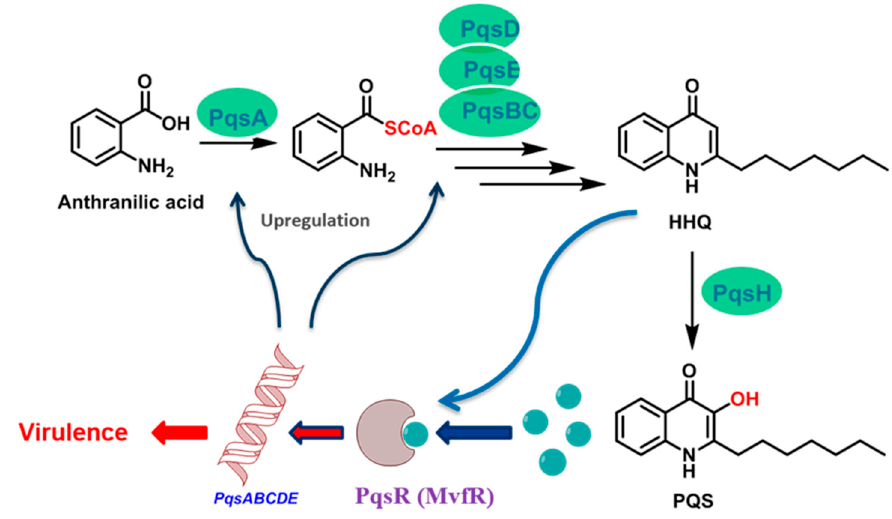
Figure 1. Schematic diagram of PQS biosynthesis, leading to activation of PqsR (MvfR) and expression of the pqsABCDE operon.